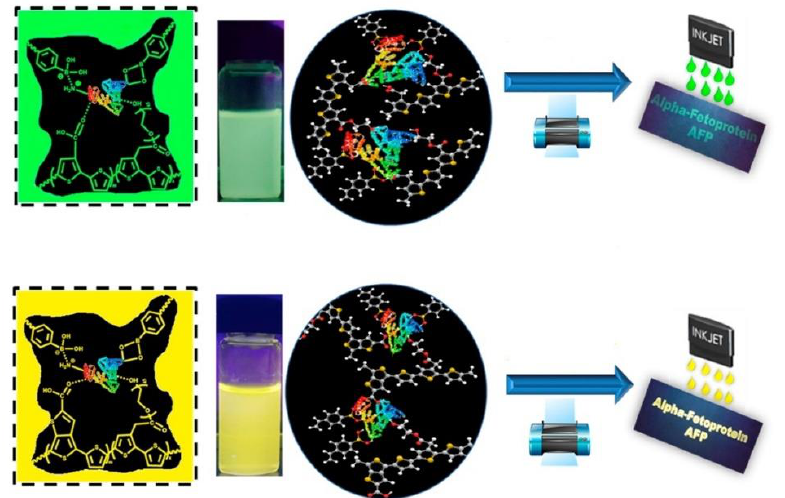
Figure 13. Illustration of the signal readout process of fluorescent conjugated polythiophene-based MIP sensors for α -fetoprotein detection. Adapted with permission [145]. Copyright 2020, Elsevier.